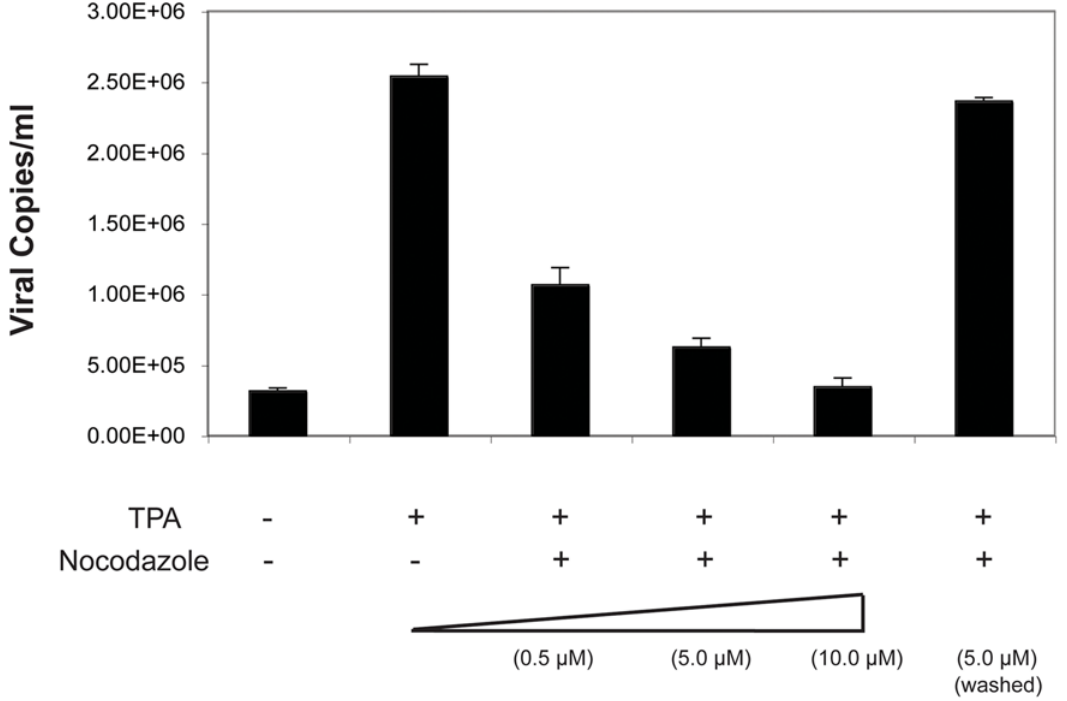
Figure 4. Effect of nocodazole on KSHV virion titers. BCBL-1 cells were treated with increasing concentrations (0.5, 5.0, 10.0 m M) of the microtubule depolymerizing drug nocodazole and induced with TPA. For nocadazole washout experiments, cells were treated with 5 m M of the drug, washed thoroughly to ensure complete removal of the drug, and then induced with TPA. Following induction, extracellular KSHV virions were collected and concentrated 100-fold. Virus stocks were treated with Turbo DNase I and viral DNAs extracted. KSHV genomic DNA concentration was estimated by a real-time PCR along with external standards of known concentrations of the viral DNA using primers against the ORF73 gene and expressed as viral DNA copy numbers per milliliter (ml) of the